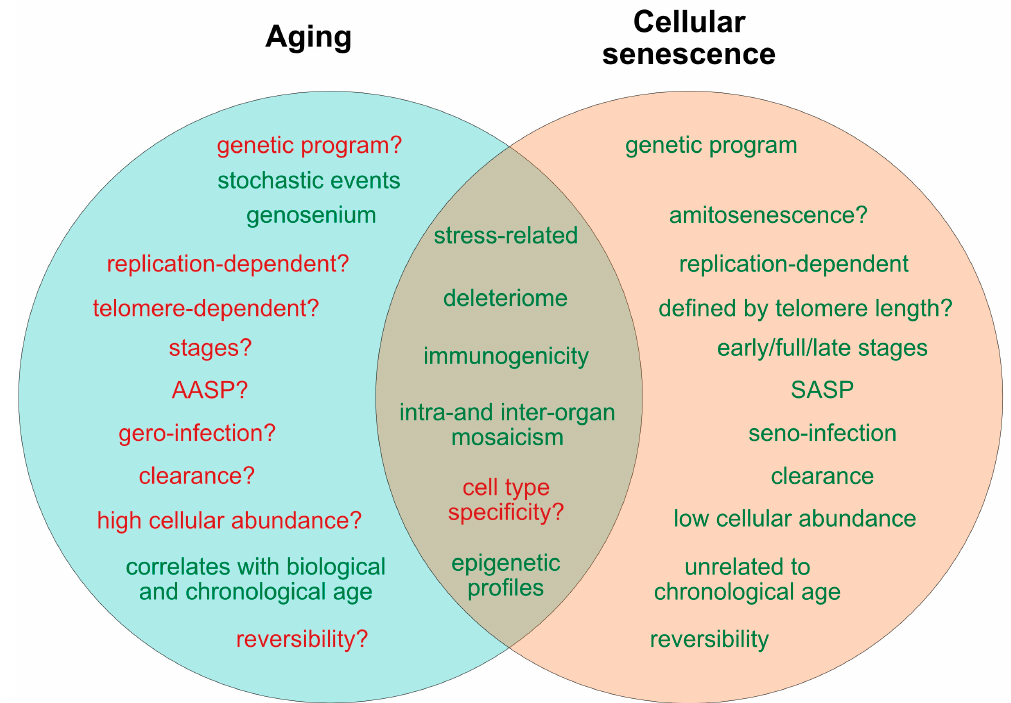
Figure 1. Current determinants and relevant open questions, marking the processes of aging and senescence as discussed in the text. Aspects represented in green are considered as broadly accepted or scientifically consolidated. Novel aspects that are yet unproven, or are under debate, are highlighted in red. SASP = senescence-associated secretory phenotype. AASP = putative aging-associated secretory phenotype as suggested in the text.